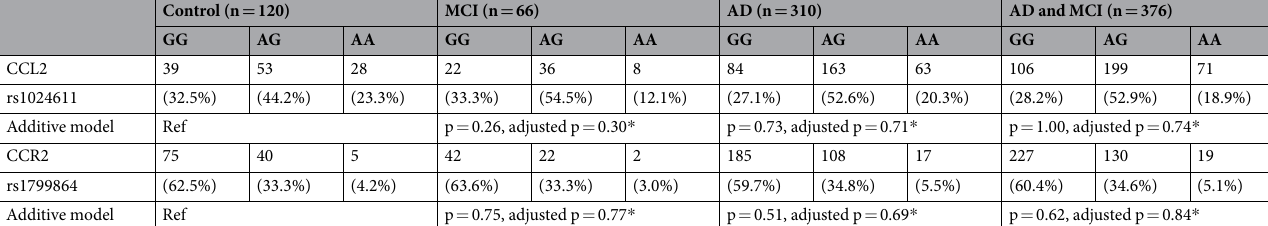
Table 5. The distribution of the CCL2 and CCR2 genotypes in AD patients, MCI patients, and control subjects. MCI, mild cognitive impairment; AD, Alzheimer’s disease; CCL2, Chemokine ligand 2; CCR2, CC-chemokine